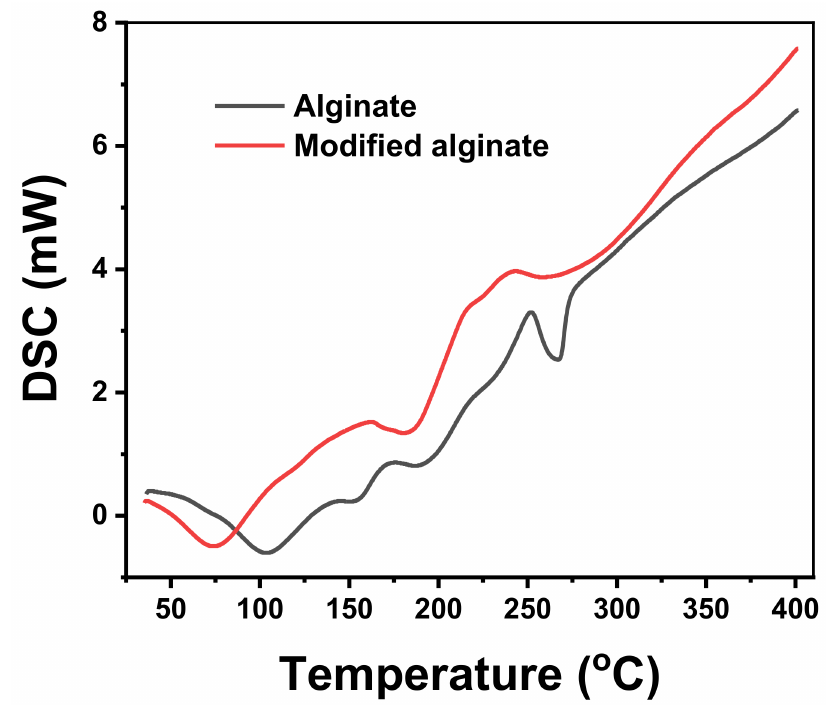
Figure 4. DSC of alginic acid and its aromatic derivative.